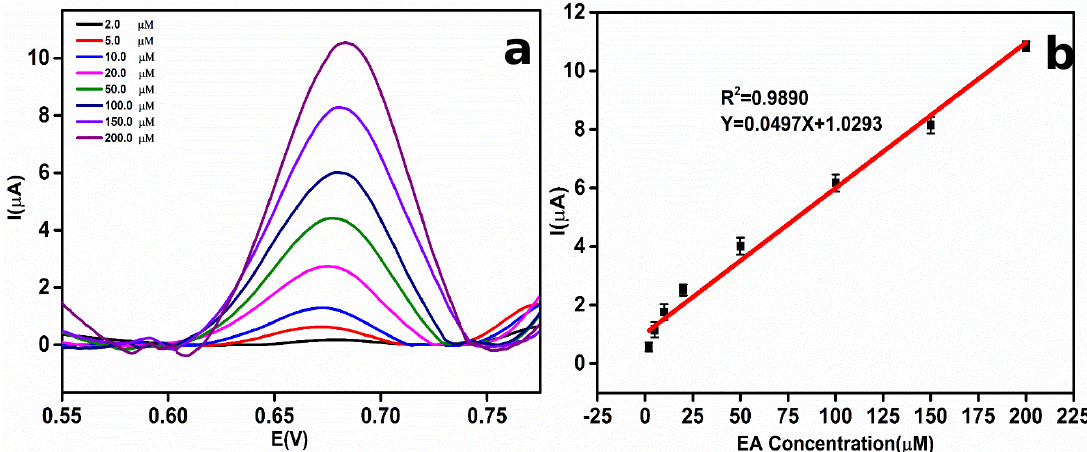
Figure 8. ( a ) Di ff erential pulse voltammetric (DPV) response of etidronic acid (EA) at di ff erent Figure 8. ( a ) Differential pulse voltammetric (DPV) response of etidronic acid (EA) at different concentrations (2.0, 5.0, 10.0, 20.0, 50.0, 100.0, 150.0, and 200.0 µ M) in 0.1 M NaOH. ( b ) Linear concentrations (2.0, 5.0, 10.0, 20.0, 50.0, 100.0, 150.0, and 200.0 μM) in 0.1 M NaOH. ( b ) Linear relationship between the EA concentration and peak relationship between the EA concentration and peak current.